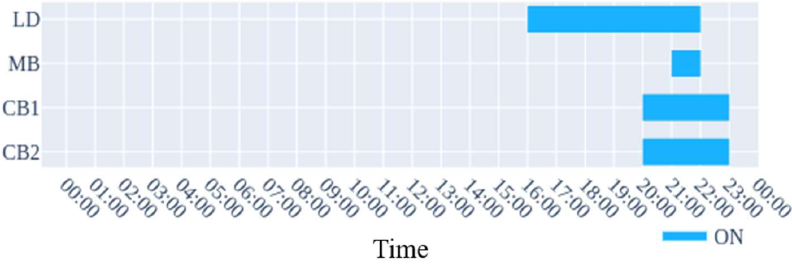
Figure 7. Cooling load usage plan (hot seasons).